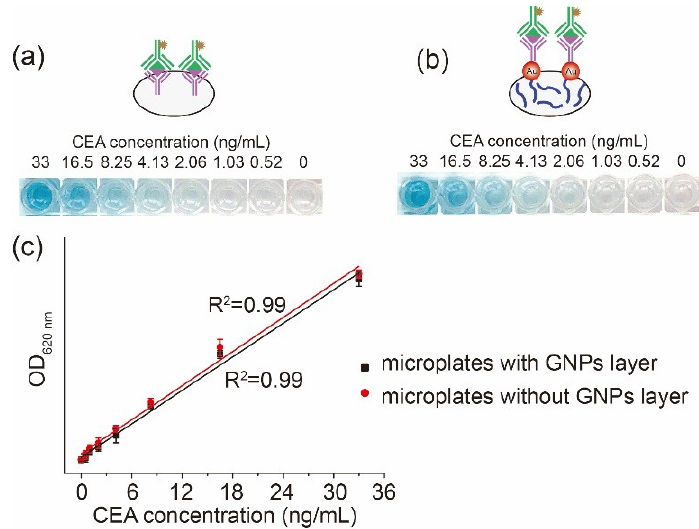
Figure 2. Results of the commercial ELISA. Pictures of the routine ELISA on the microplate without ( a ) and with ( b ) a 13 nm GNP layer. OD 620 vs. CEA concentration of the routine ELISA on the microplate without and with a GNP layer ( c ).